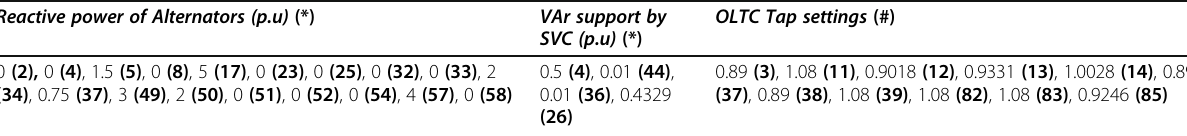
*indicates bus number #indicates line number